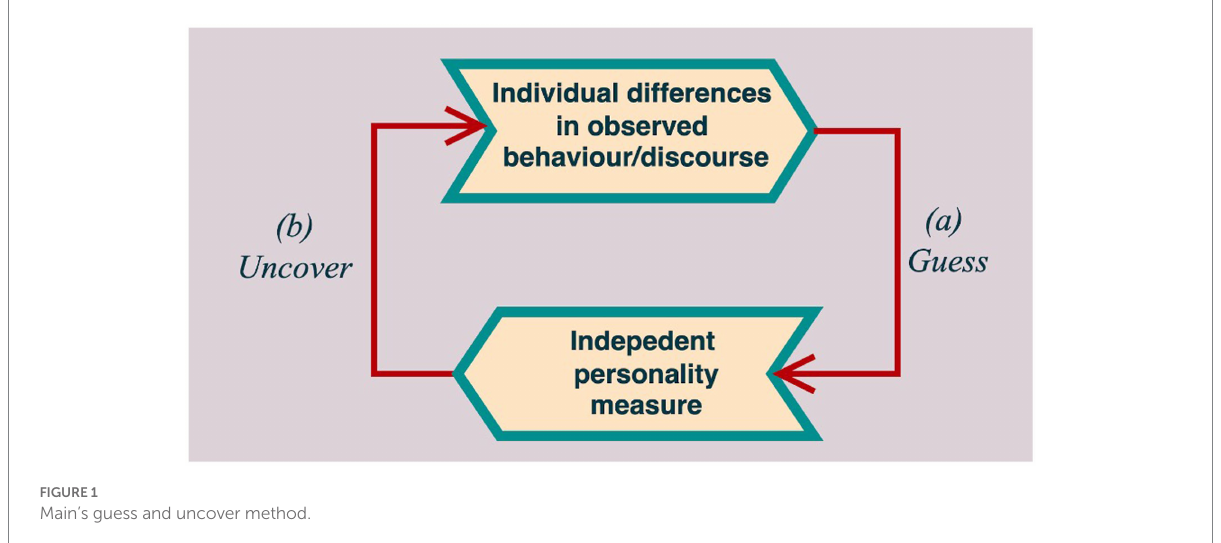
FIGURE 1 Main’s guess and uncover